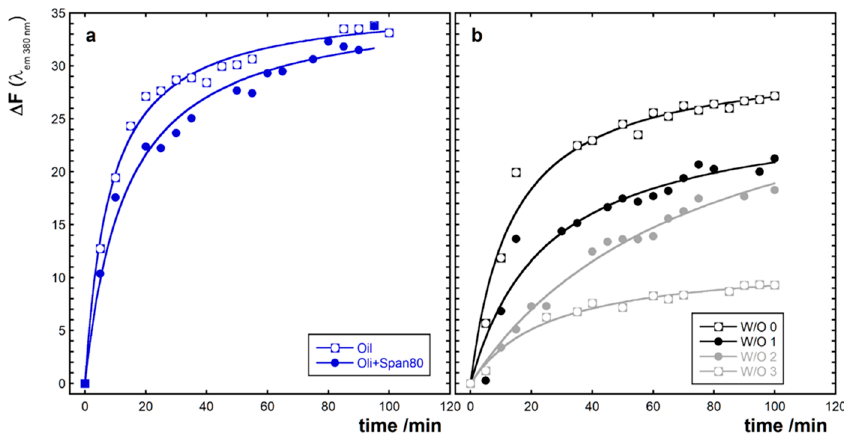
Figure 2. Kinetics of oxidation expressed as fluorescent response to the reaction between hydroperoxides generated by the radical initiator 2,2 ′ -azobis(2,4-dimethylvaleronitrile) (AMVN) and diphenyl1-pyrenylphosphine (DPPP) to give the fluorescent oxide DPPP = O. The kinetics are relative to oil and oil + Span 80 ( a ) and to W / O emulsions ( b ). W / O emulsions stabilized with 1% Span 80 in the presence of increasing concentrations of red wine extract (W / O 0; W / O 1; W / O 2; W / O 3). Data reported are the mean value of three replicates.